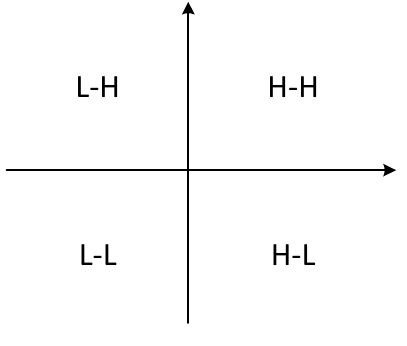
Figure 4. Moran scatter image limit